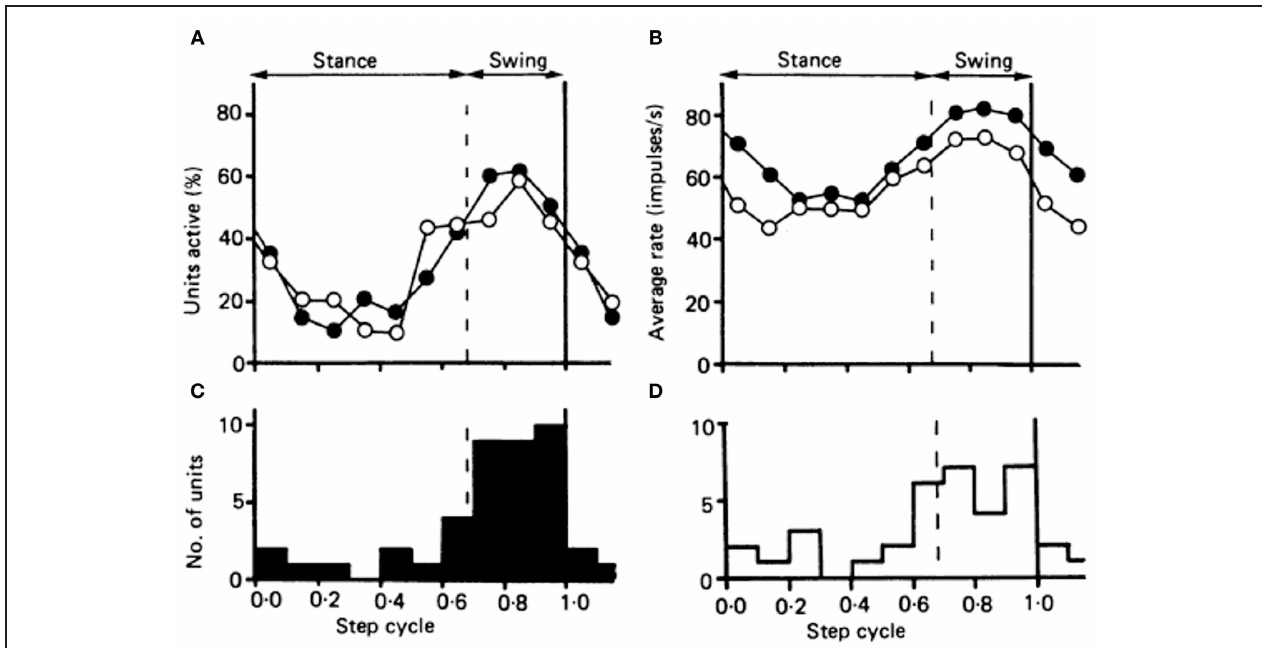
rate amongst the two populations during the course of the step cycle. Open circles represent the Purkinje cells of the cl zone; and filled circles the interpositus neurons. (C and D) Histograms showing the number of neurons attaining their peak discharge rate during each tenth of the step cycle, for the interpositus neurons and the Purkinje cells of the cl zone respectively. Reprinted from Armstrong and Edgley (1984b), with